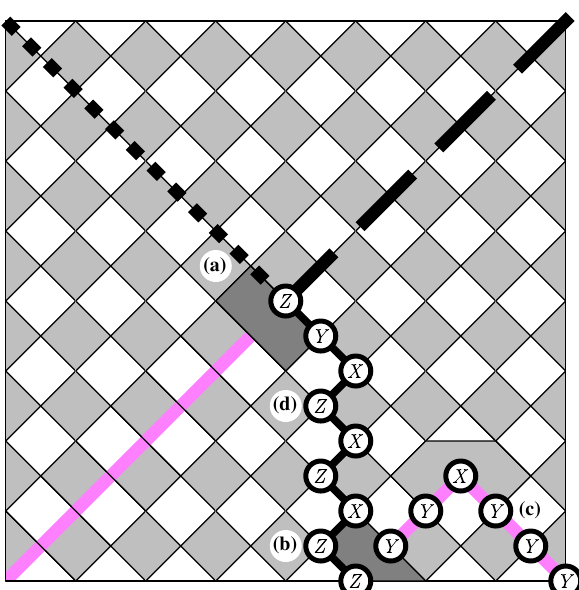
FIG. 8. Spacetime figure showing the evolution of the logical ¯ X operator under the exchange of two twists, where the time FIG. 9. By rotating the lattice geometry about an angle of π = 4 , direction is upwards along the page. The figure shows that the we can perform both twist exchange operations without reducing ¯ Y the distance beyond a small constant value. The figure shows a operator is mapped onto the logical operator , which can be distance L ¼ 9 lattice. (a,b) Two twist defects that have been seen at the top of the figure. The trajectory of the twist defects deformed into the center of the lattice. (c) The single-qubit is marked by black lines. As in the two-dimensional figures measurements we make to move the twist along the bottom of the above, red (blue) strings correspond to the world lines of e ( m ) lattice. (d) A weight-nine logical operator at a moment where the quasiparticle excitations. We continue with the convention we two twists pass each other. The black dashed and dotted lines used earlier, where e charges can terminate at the boundary. We show the support of conjugate weight-nine logical operators that depict this by showing red strings diverging away from the twist we find to be minimal in defects.